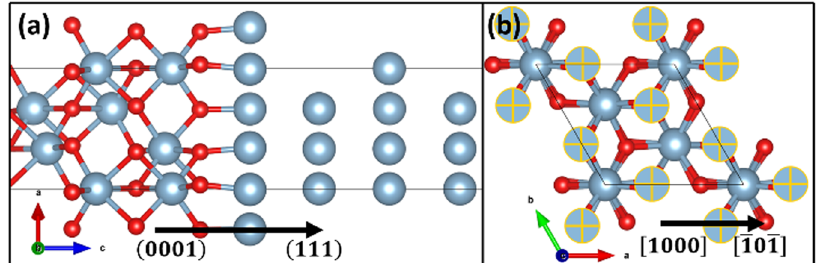
Fig. 1 Post-relaxation reference structure, with red and gray atoms are O and Al respectively, and yellow cross marks interface Al atoms. a Side view showing epitaxial growth. b Top view showing parallel lattice directions of the metal cap and oxide.